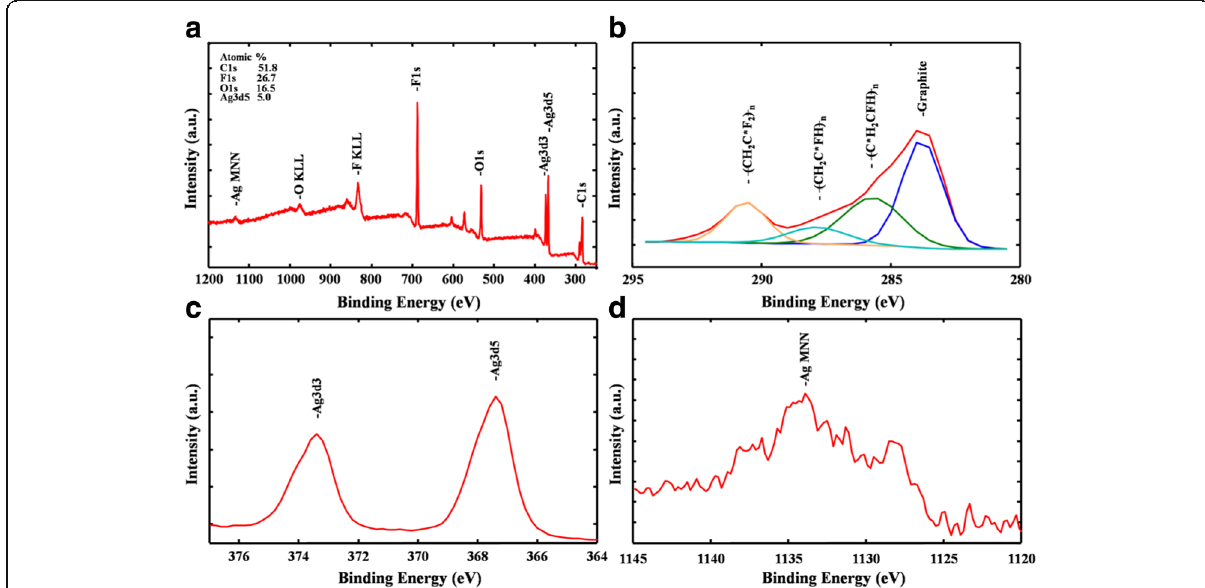
Fig. 2 X-ray photoelectron spectroscopy spectra of the Ag/CMK-8 membrane. a Survey spectrum. b C1s. c Ag3d. d Ag